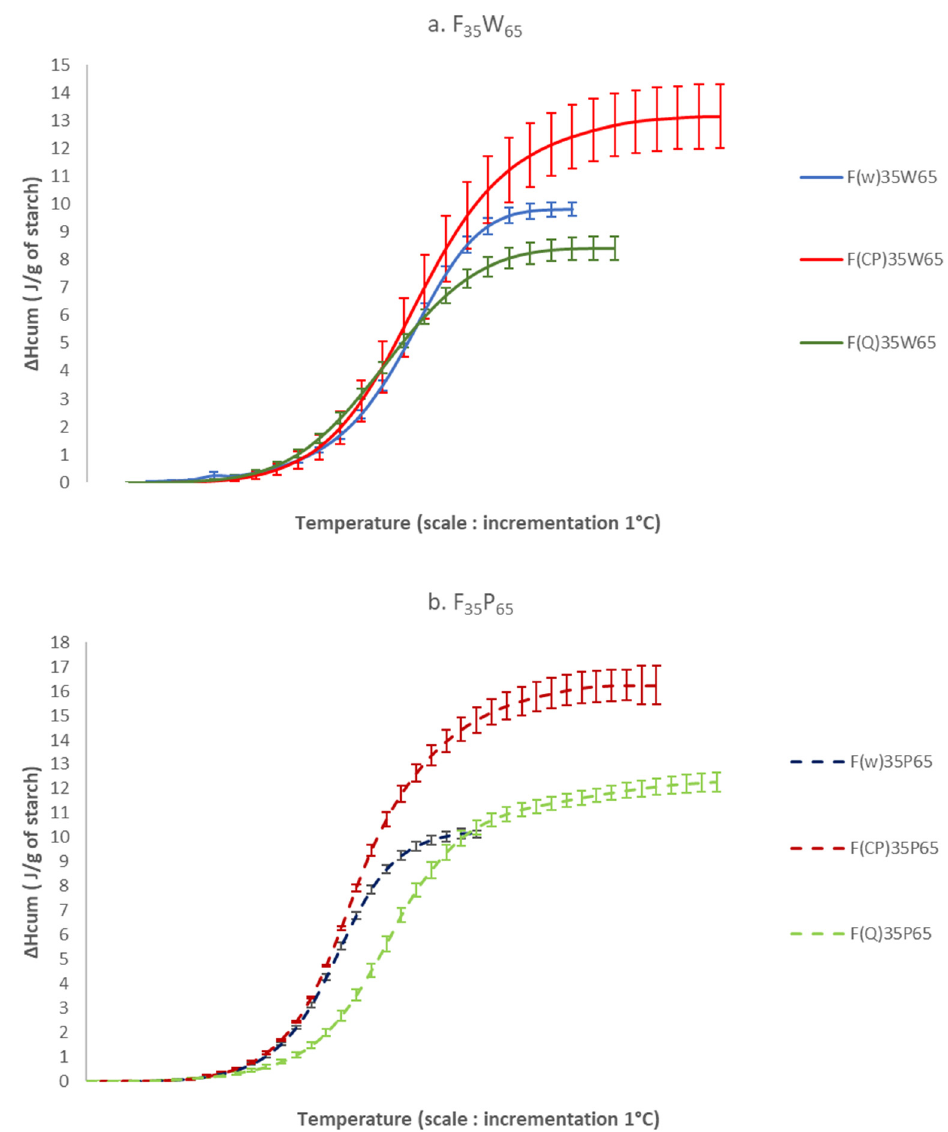
Figure 4 . Superimpositions of the cumulative enthalpy curves for the F 35 W 65 mixtures ( a ) and the F 35 P 65 mixtures ( b ) .